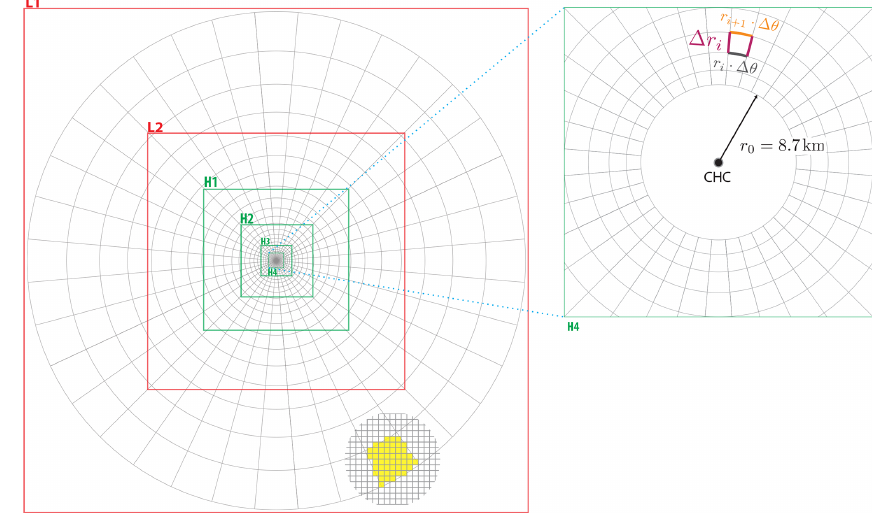
Figure A1. Schematic of the rectangular-to-log-polar regridding. See Sect. A2 for a full description.